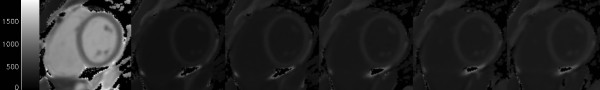
Human Study. Mid-ventricular short axis T1 maps. From left to right: pre-contrast, 5 minutes, 8.5 minutes, 13.5 minutes, 18.5 minutes and 23.5 minutes post-contrast. All images were displayed with same setting.